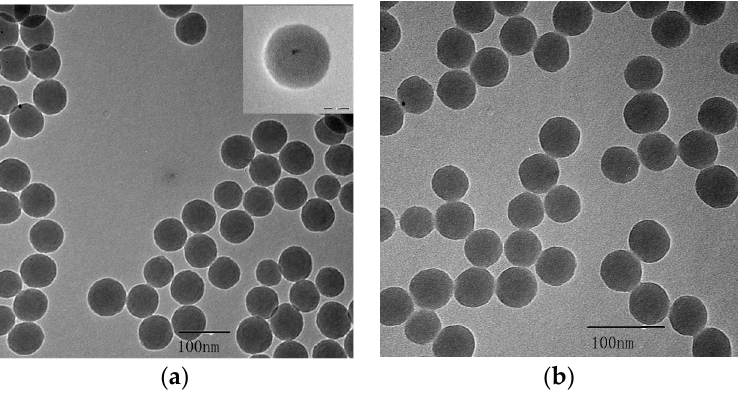
Figure 3. TEM of ( a ) CdTe/SiO 2 and ( b ) carboxyl-modified CdTe/SiO 2 particles.